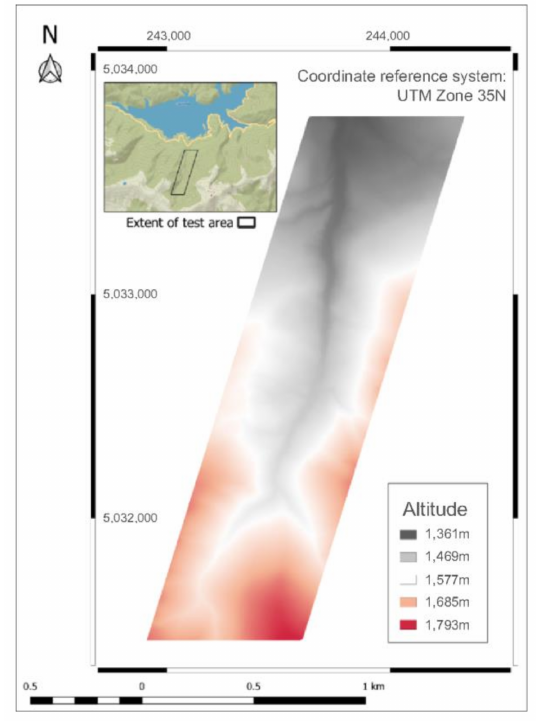
Figure 1. Location of test